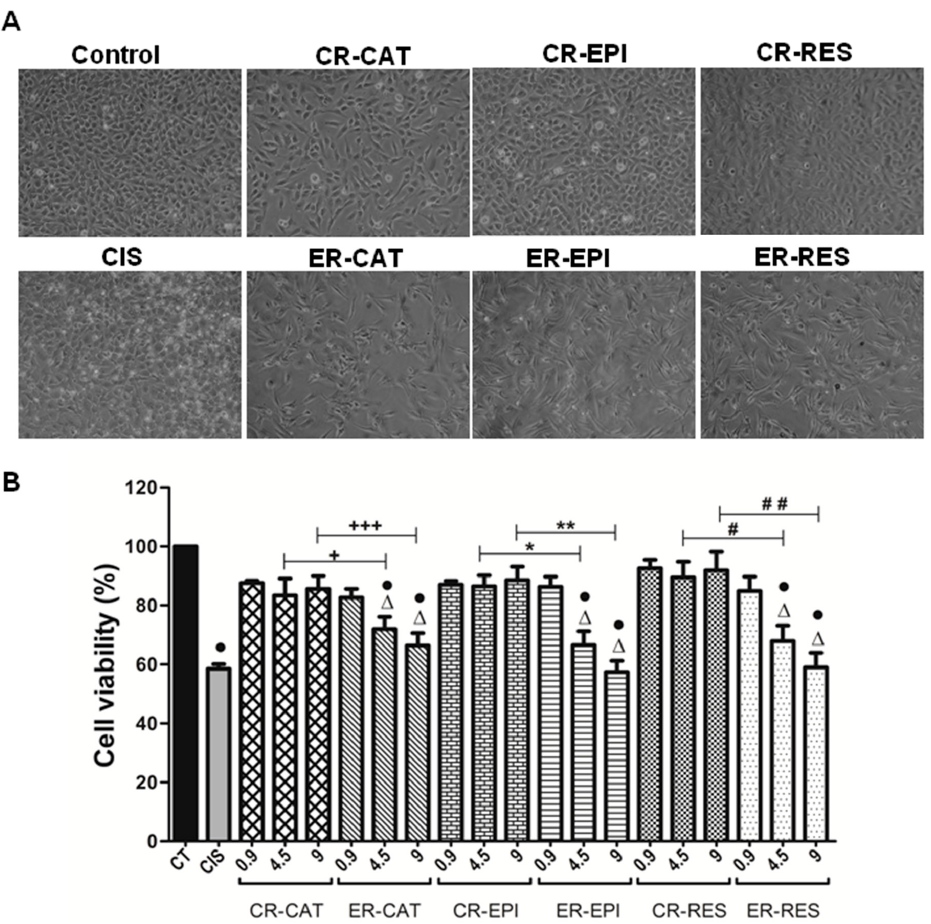
Figure 4. Cell damage in T24 bladder cancer cells induced by cisplatin and the products of the control (CR) and enzymatic (ER) reaction of catechin (CAT), epicatechin (EPI), and resveratrol (RES). ( A ) Representative images (10 × ) of the T24 cells’ density obtained by phase contrast microscopy and ( B ) cell viability of T24 cells assessed by the 3-(4,5-dimethylthiazol-2-yl)-2, 5-diphenyltetrazolium bromide (MTT) assay after di ff erent treatments after 24 h. T24 cells were treated for 24 h with cisplatin (10 mM CIS) or with different concentrations (0.9, 4.5 and 9 μ M CE) of the CR and enzymatic ER of CAT, EPI, and RES. Control (CT) cells were treated for 24 h with 2% dimethyl sulfoxide (DMSO). Data are mean ± SEM, n = 3. • p < 0.05 vs. CT, + p < 0.0229 CR-CAT vs. ER-CAT (4.5 µ M), +++ p < 0.0001 CR-CAT vs. ER-CAT (9 µ M), * p < 0.0381 CR-EPI vs. ER-EPI (4.5 µ M), ** p < 0.0018 CR-EPI